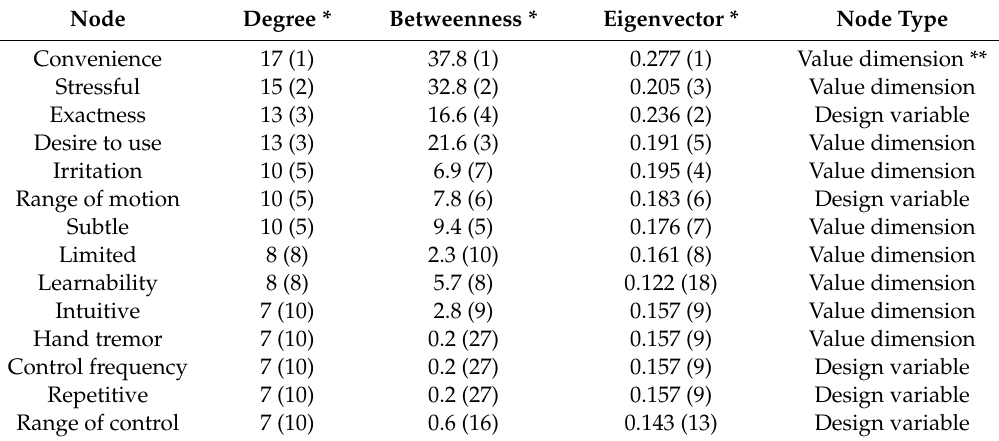
Table 4. Centrality of representative nodes associated with fatigue.